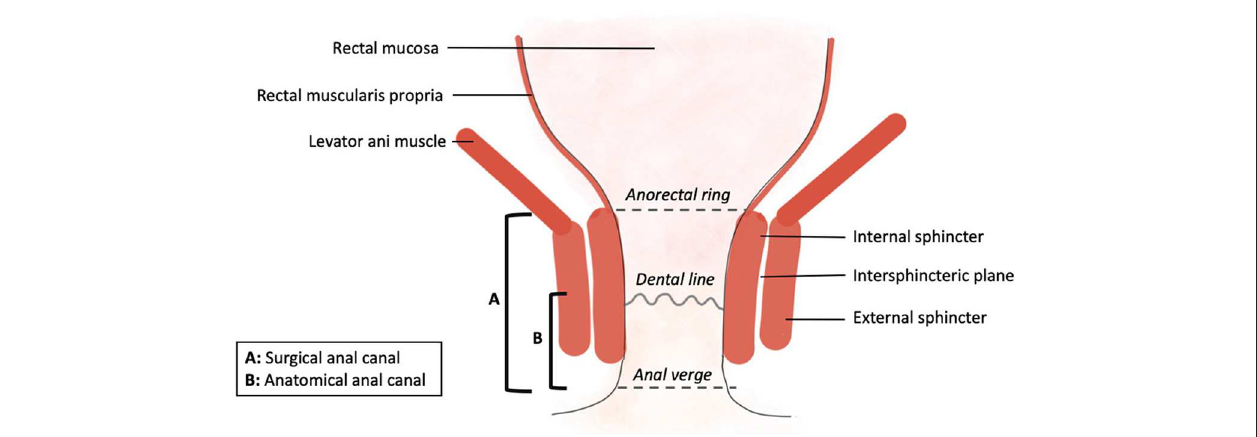
FIGURE 1 | Anatomy of the very low